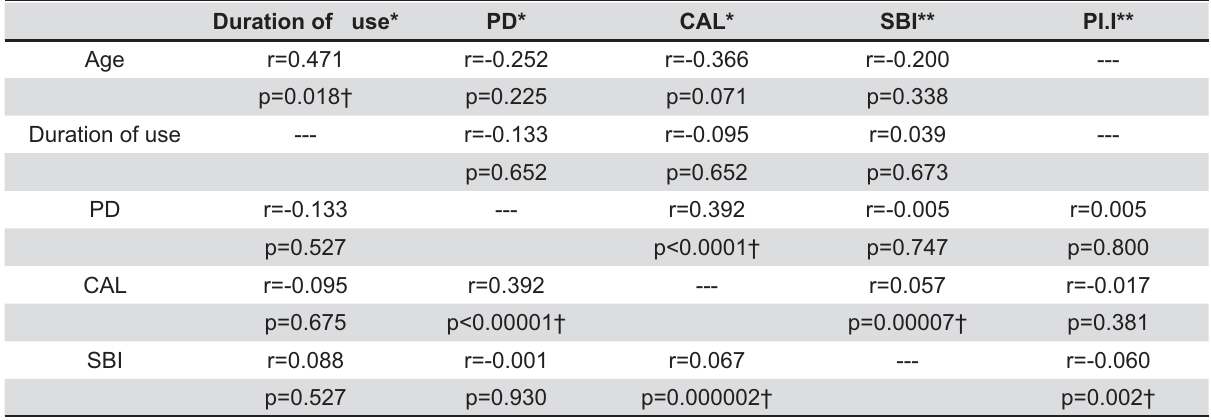
Table 2- Correlation between age, total duration of oral contraceptive therapy and clinical periodontal parameters in test group